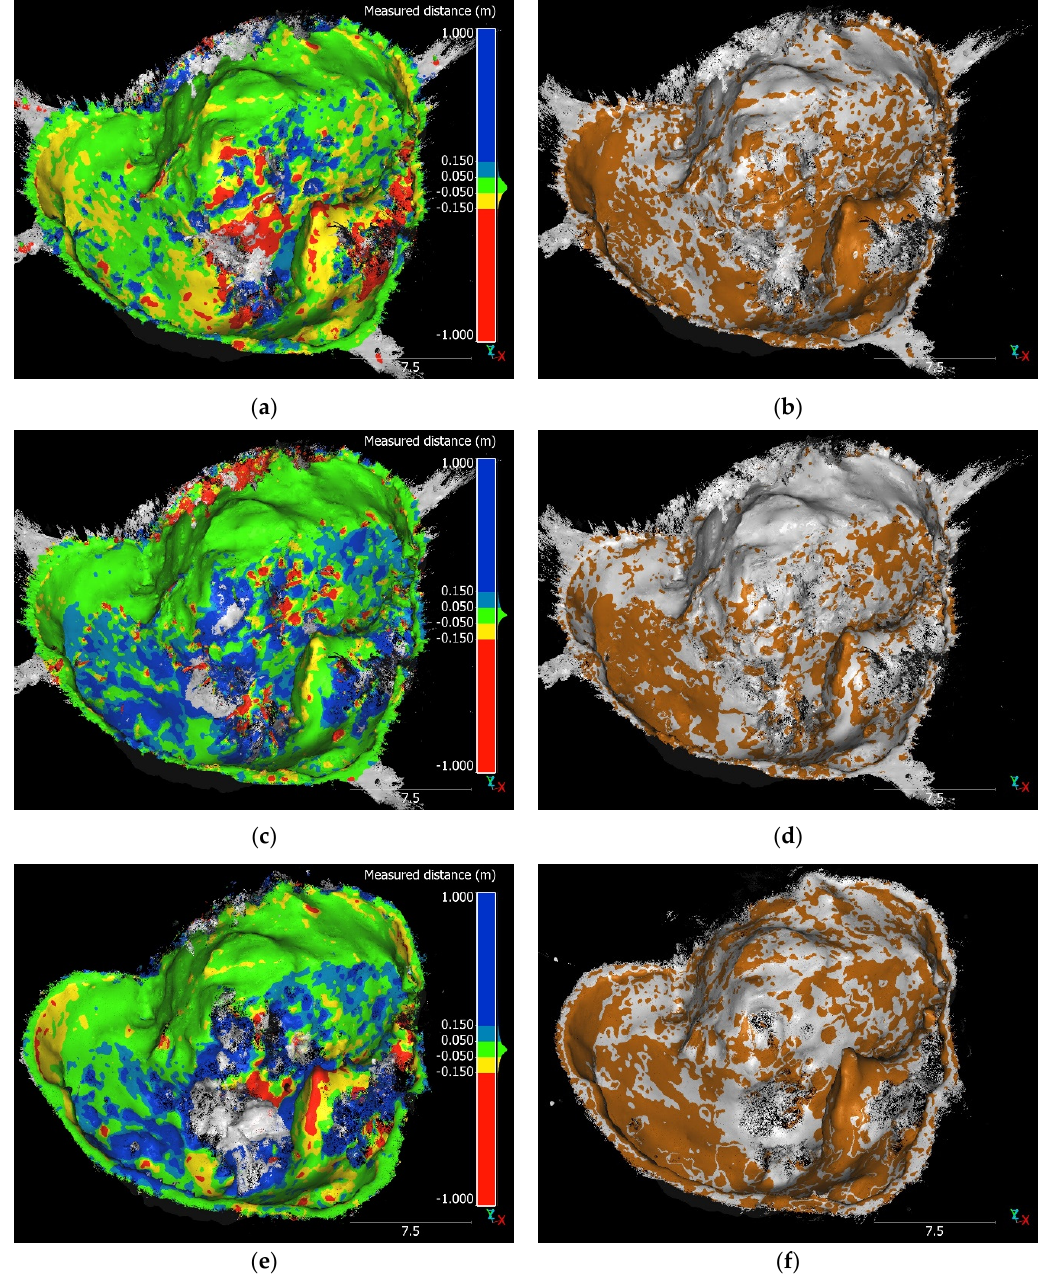
Figure 5. Measured distances and regions of detectable change for comparisons UAV 2017/18, 2018/19, and 2017/19 (see Table 4): ( a ) UAV 2017/18 measured distance (m), UAV 2017/18: measured distances of UAV 2017 to UAV 2018. ( b ) UAV 2017/18 detectable change, UAV 2017/18: detectable change of UAV 2017 to UAV 2018. ( c ) UAV 2018/19 measured distance (m), UAV 2018/19: measured distances of UAV 2018 to UAV 2019. ( d ) UAV 2018/19 detectable change, UAV 2018/19: detectable change of UAV 2018 to UAV 2019. ( e ) UAV 2017/19 measured distance (m), UAV 2017/19: measured distances of UAV 2017 to UAV 2019. ( f ) UAV 2017/19 detectable change, UAV 2017/19: detectable change of UAV 2017 to UAV 2019. Note the different information portrayed by the color gray: in ( a , c , e ), gray areas show areas where no change was measured (due to missing points or the maxi- mum depth of 1 m was exceeded); in ( b , d , f ), the gray color shows points with no detectable change. 4. Discussion 4.1. Comparing Terrestrial and UAV Patterns of Change Looking at the results of comparing the point clouds resulting from terrestrial or aer- ial imagery from the same year, the sometimes small (2019) or larger differences (2017) between the point clouds are to some extent surprising. As this is a comparison of sensors with data taken at the same day within minutes of each other, we can safely assume no change of the sinkhole happened between acquisition of the aerial and terrestrial imagery. All differences measured here are produced by the different sensors, perspective, camera locations, and SfM and MVS processes. Particularly, the differences in the 2017 point cloud pair showing large differences on the sinkhole floor are interesting. We assume the higher position may be attributed to the limited viewing angles of the terrestrial camera resulting in a bad image quality in areas of the sinkhole floor. It could also be related to some sort of doming effect resulting from poor camera and ground control point positioning. These errors are explicitly not portrayed in the point precision maps [5]. However, with the 2019 terrestrial survey design being very similar, this different representation of the sinkhole floor did not happen then. Therefore, the exact reason for the difference remains unclear. The small but detectable differences between the point clouds resulting from the two sen- sors in 2019 show a pattern that may be attributed to point precision variations resulting from the randomness during photogrammetry 3D reconstruction [38,53,54] and/or to dif- ferences in the reconstruction of the vegetation on the sinkhole floor (such as due to grad- ual filtering or vegetation movement). With the multitemporal comparison using the same survey method but point clouds of different years, we had different challenges. While we have no means of knowing which measured distances portray the real change within the sinkhole over time, we can apply general geomorphological knowledge and principles to evaluate the validity or plausibil- ity of the changes we measured. Additionally, it is beneficial to only look at mainly vege- tation-free areas or areas with only very low vegetation. In these areas, the influences of the gradual filtering tool and the vegetation movement and growth during and in between the surveys are assumed to play no role in the point cloud quality or the spatial pattern of